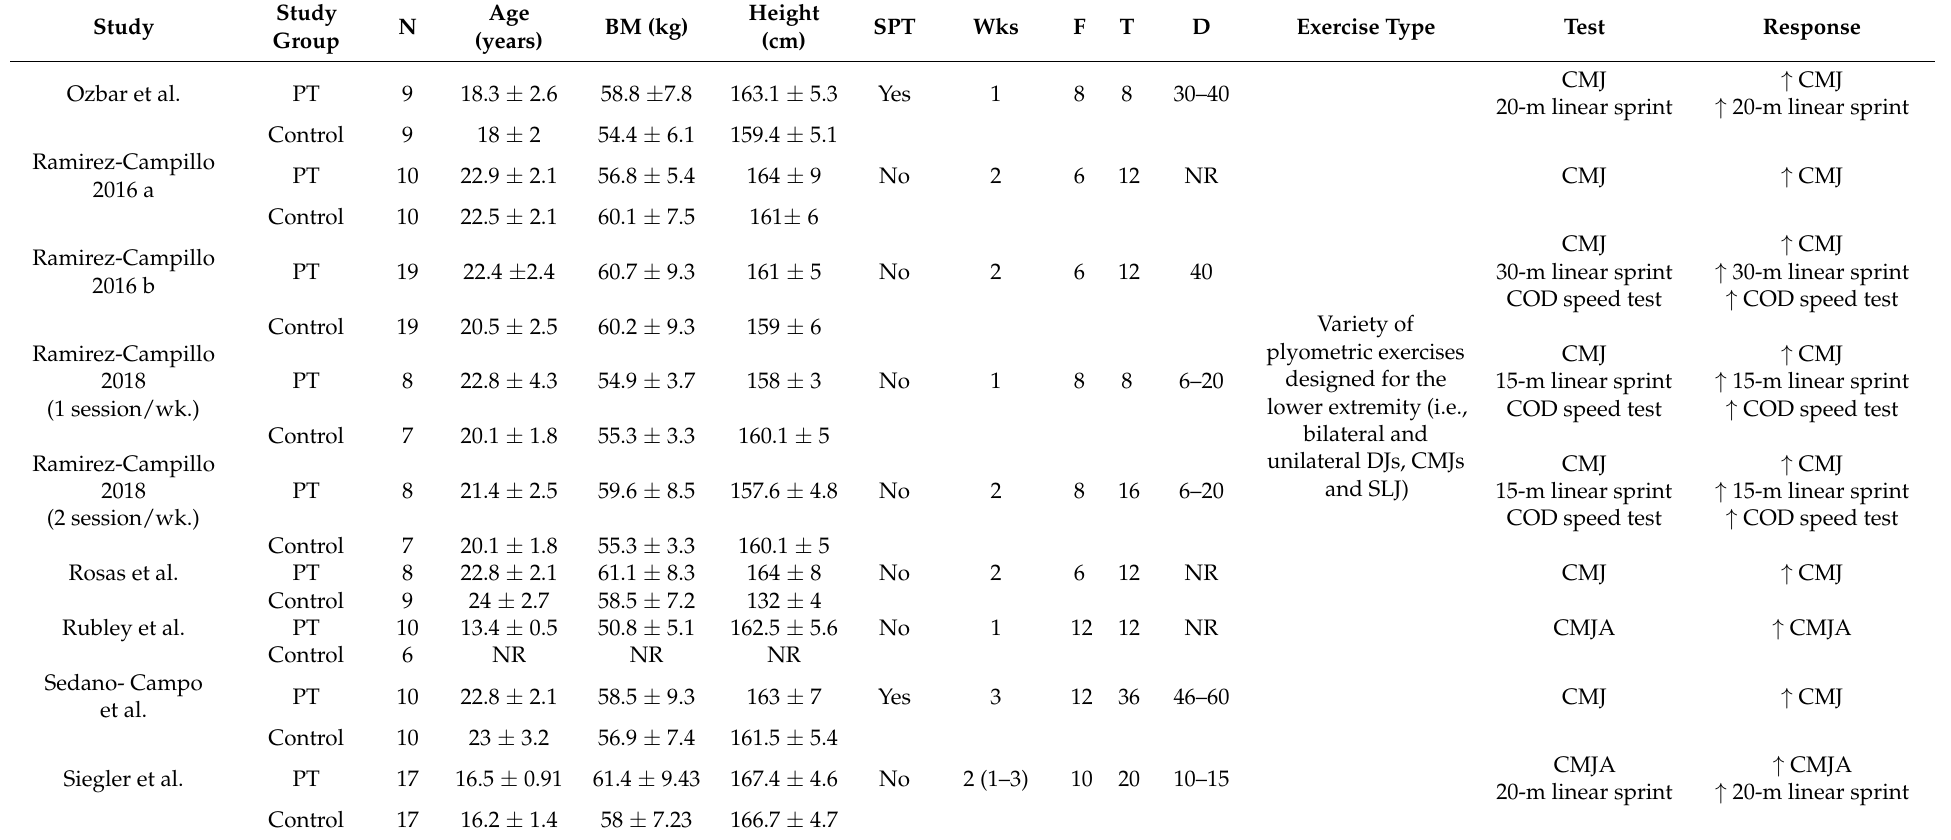
Table 3. Characteristics of study participants of plyometric